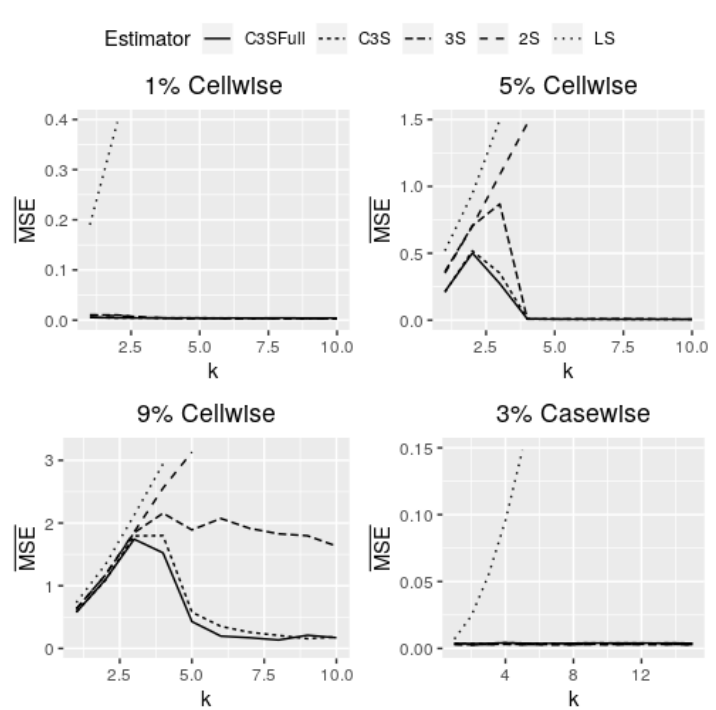
Figure 6. MSE for indicated cell-wise and case-wise contamination values k in models with continuous covariates and n = 500. Source: the